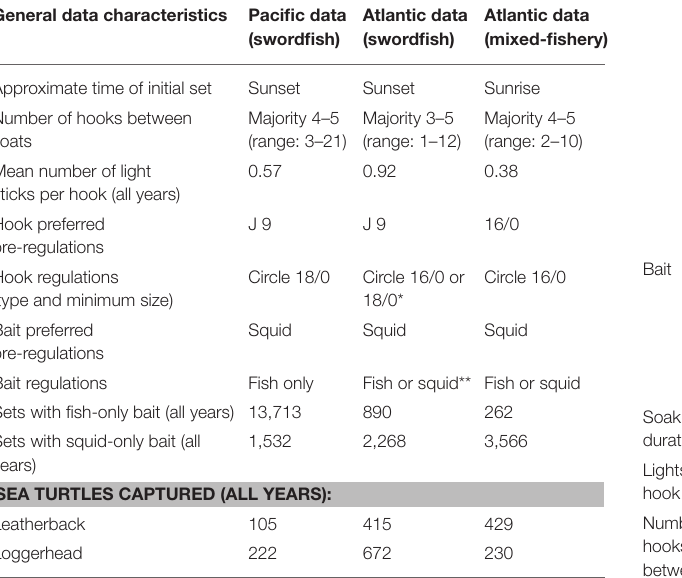
TABLE 1 | General characteristics and sample sizes for observer data from the Pacific Hawaii-based shallow-set longline fishery, the Atlantic swordfish-set longline fishery, and Atlantic mixed-set longline fishery from ∼ 1992 to 2014.